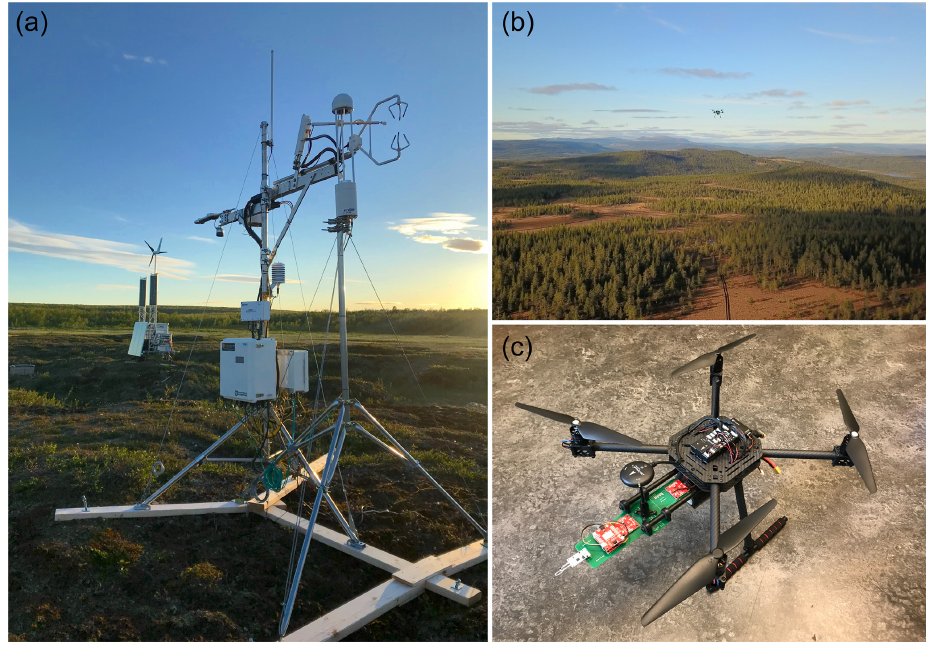
Figure 2. Examples of field sites and equipment. (a) Eddy covariance tower at the Iškoras palsa mire. (b) Drone above the Hisåsen site (photo by Pierre-Marie Lefeuvre). (c) Drone with